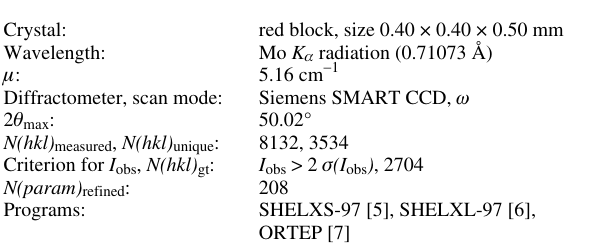
Table 1. Data collection and handling.